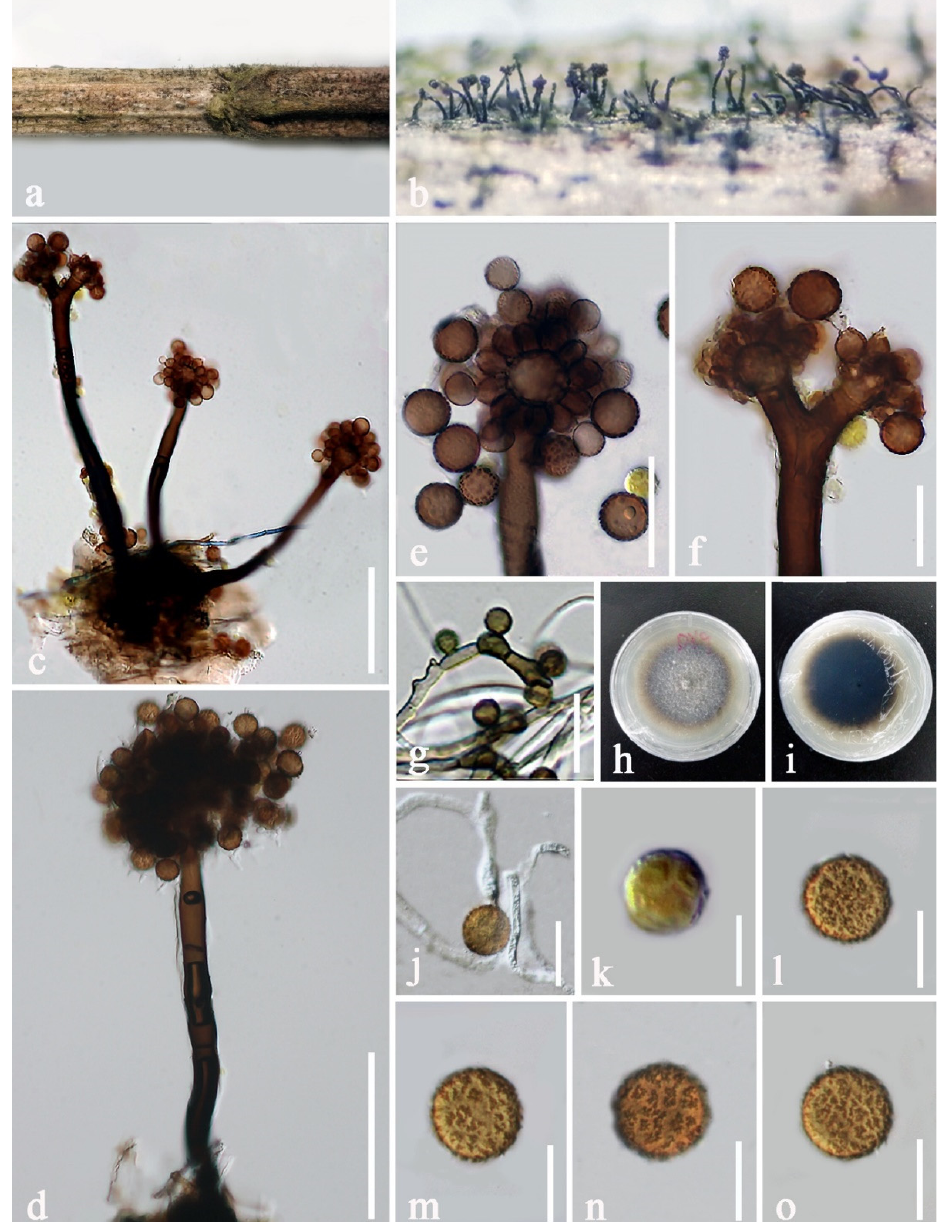
Figure 3. Periconia artemisiae (KUN-HKAS 107384, holotype). ( a ) Colonies on the host substrate; ( b ) close-up of colonies on substrate; ( c , d ) conidiophores; ( e , f ) conidial heads bearing conidiogenous cells and conidia. ( g ) conidia sporulated on PDA after three months. ( h , i ) colony on PDA (( h ) = from above, ( i ) = from below)); ( j ) germinating conidium; ( k – o ) conidia. Scale bars: ( c , d ) = 100 µm, ( e , f ) = 30 µm, ( j ) = 20 µm, g, ( l – o ) = 15 µm, ( k ) = 10 µm.